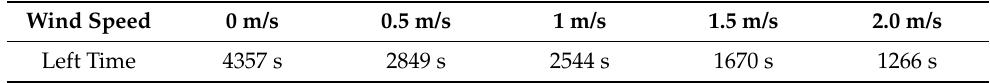
Figure 2. Evolution of evaporating droplets on peach leaves at different wind speeds. Table 1. Time taken for water droplets to evaporate at different wind